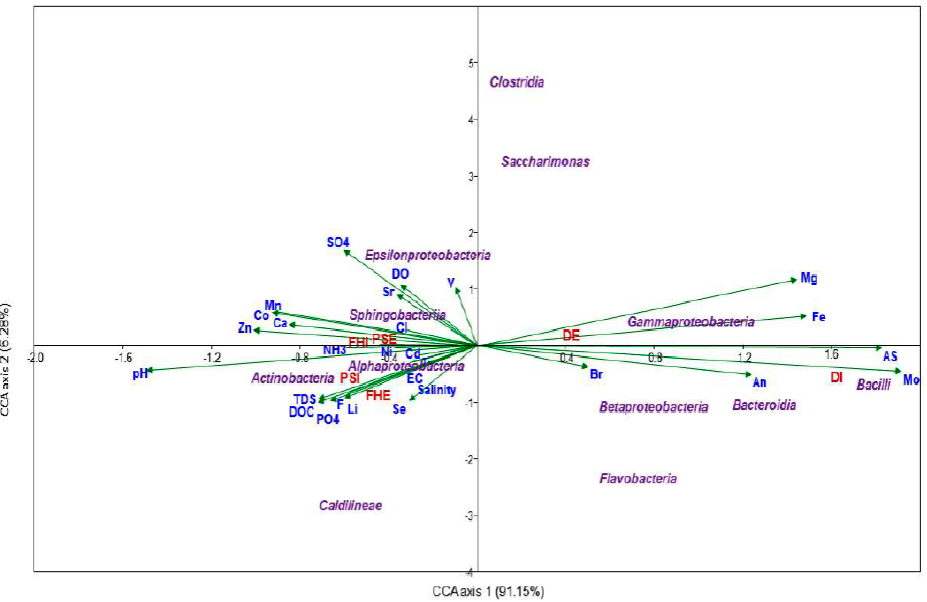
Figure 4. Canonical correspondence analysis (CCA) ordination plot shows the effect of physicochemical parameters on bacterial community structures (classes) in three different WWTPs.